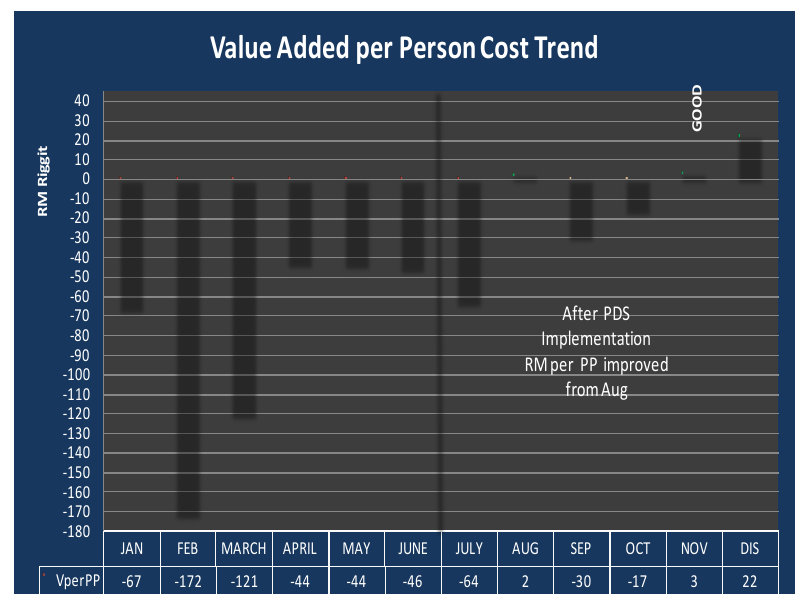
Figure 20. “Value Added per Person Cost Trend